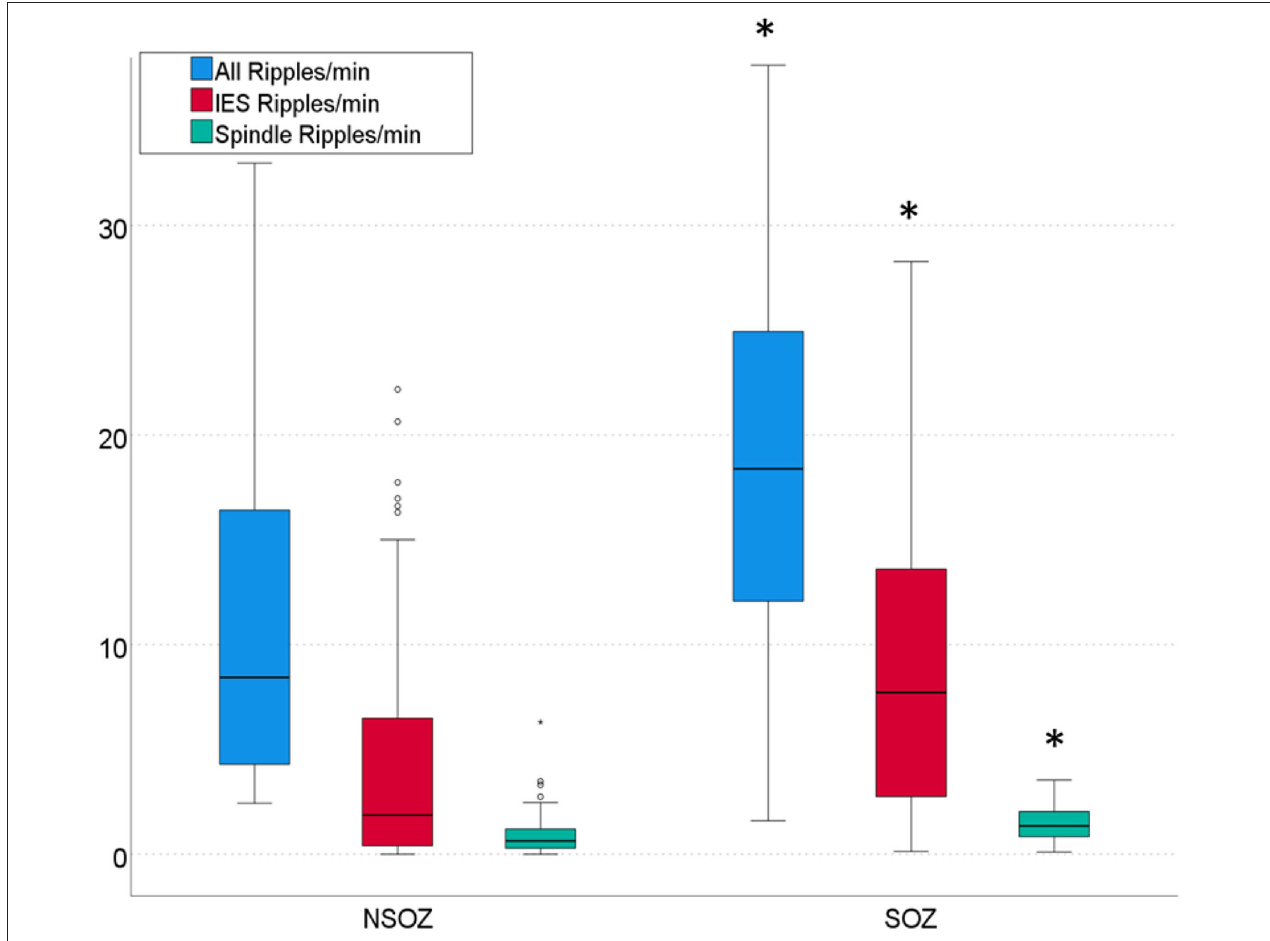
FIGURE 2 | Rates of three ripple types per min in channels outside the seizure onset zone (NSOZ) compared to ripples in channels inside the seizure onset zone (SOZ). Significantly higher overall ripple, IES ripple, and Spindle ripple rates were found in SOZ channels ( * p < 0.001, respectively).